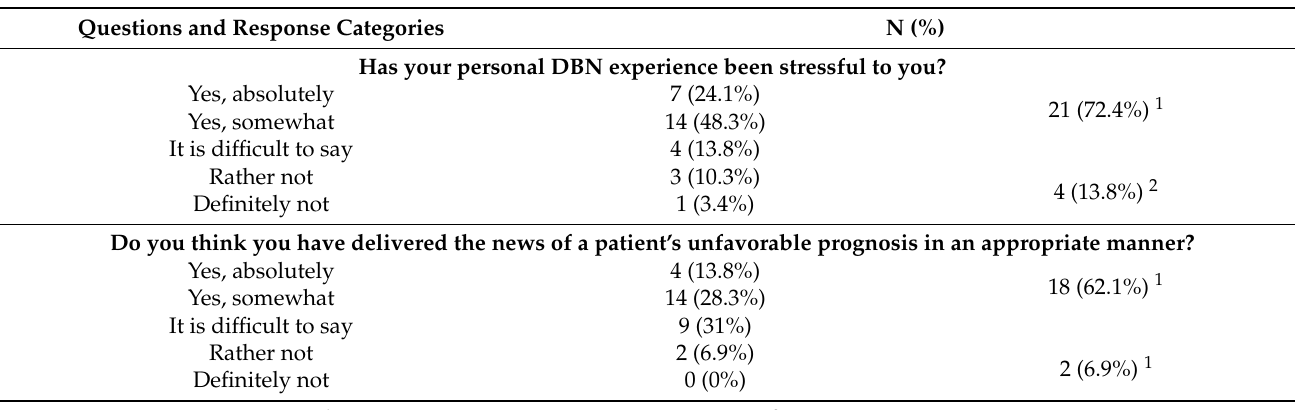
Table 3. Assessment of personal experience in